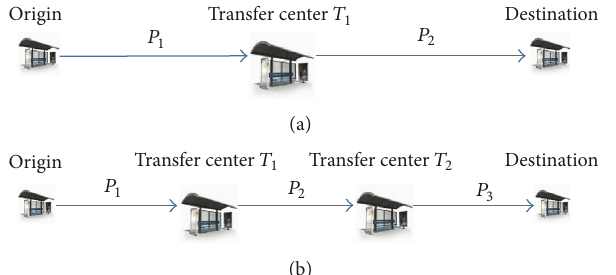
Figure 6: Path-finding process between two stops through one transfer center (a) and two stops through two transfer centers (b).